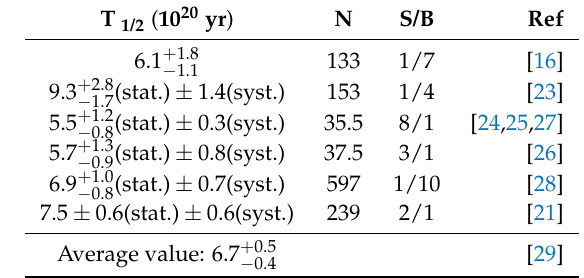
Table 2. Present positive results on T 1/2 of the 2 β − decay of 100 Mo to the first 0 + excited state of 100 Ru. N is the number of detected events or coincidences and S/B is the signal/background